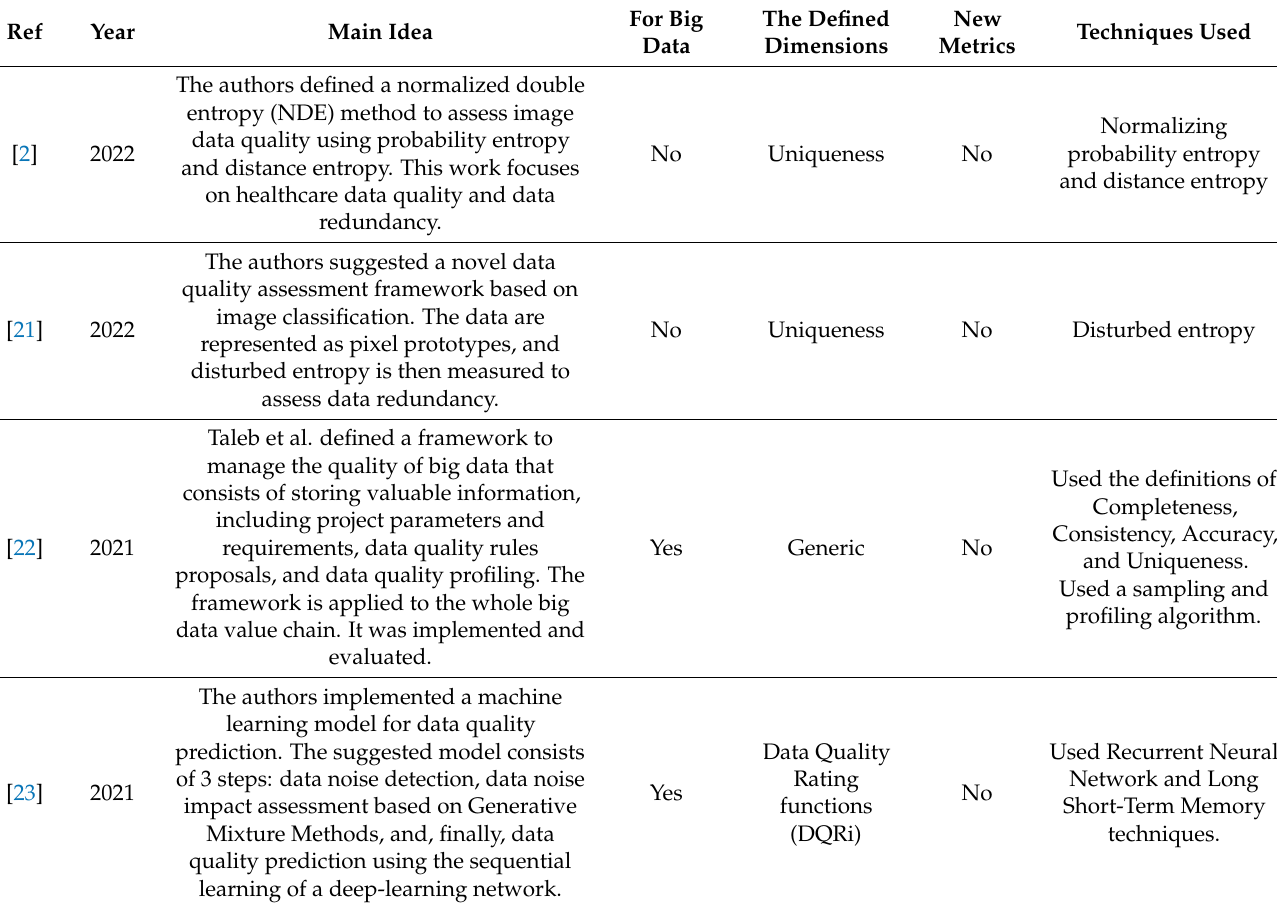
Table 2. Approaches addressing data quality